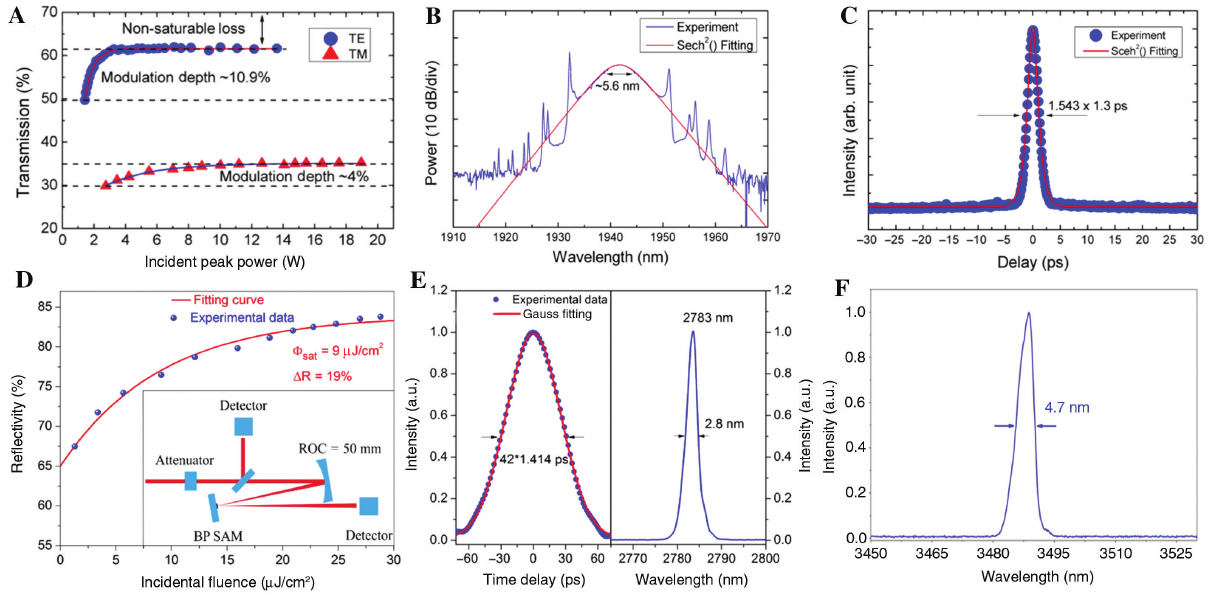
saturable absorber (SA). Figure 7: Mode-locked fiber lasers using WS 2 (A) Nonlinear transmission curves at 1925 nm. (B) Spectrum. (C) Autocorrelation traces. Reproduced with permission [185]. Copyright 2015, The Optical Society. Mode-locked Er: ZBLAN fiber laser at 2.8 μ m and 3.5 μ m. (D) Saturable absorption of black phosphorus (BP) SA at 2.8 μ m. (E) Autocorrelation trace and spectrum at 2.8 μ m. Reproduced with permission [186]. Copyright 2016, The Optical Society. (F) Spectrum at 3.5 μ m. Reproduced with permission [131]. Copyright 2018, The Optical